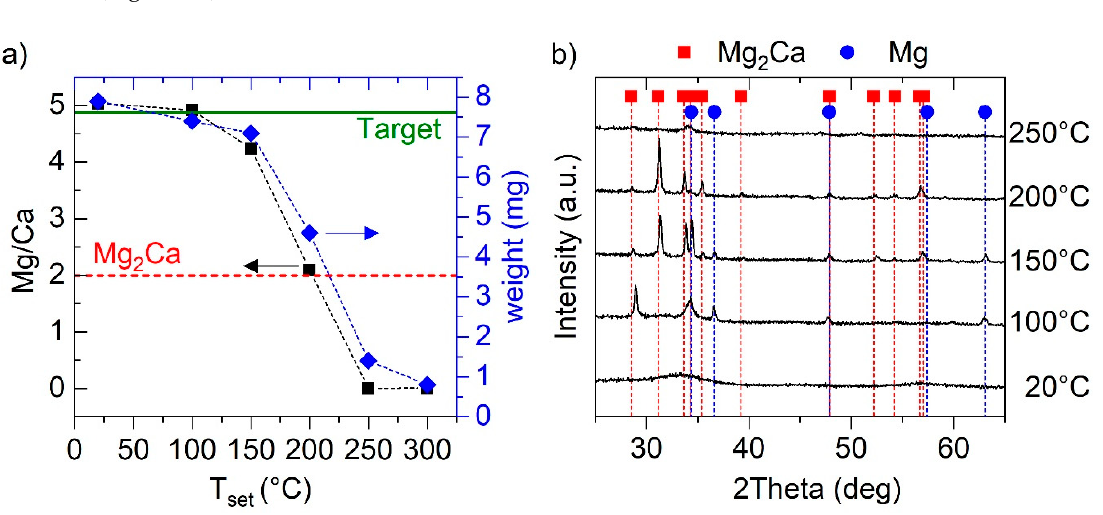
Figure 1. ( a ) Measured Mg/Ca ratio (EDX) and weight of as-deposited Mg–Ca thin films as a function of the set temperature. The temperature was varied from room temperature (no intentional heating, approximately 20 °C) to 300 °C, while keeping the deposition time (60 min) constant. As a guide for the eye, the Mg/Ca ratios of the utilized sputtering target (horizontal solid line) and of stoichiometric intermetallic Mg 2 Ca (horizontal dashed line) are added. ( b ) Corresponding diffractograms of the samples deposited at the indicated temperatures.